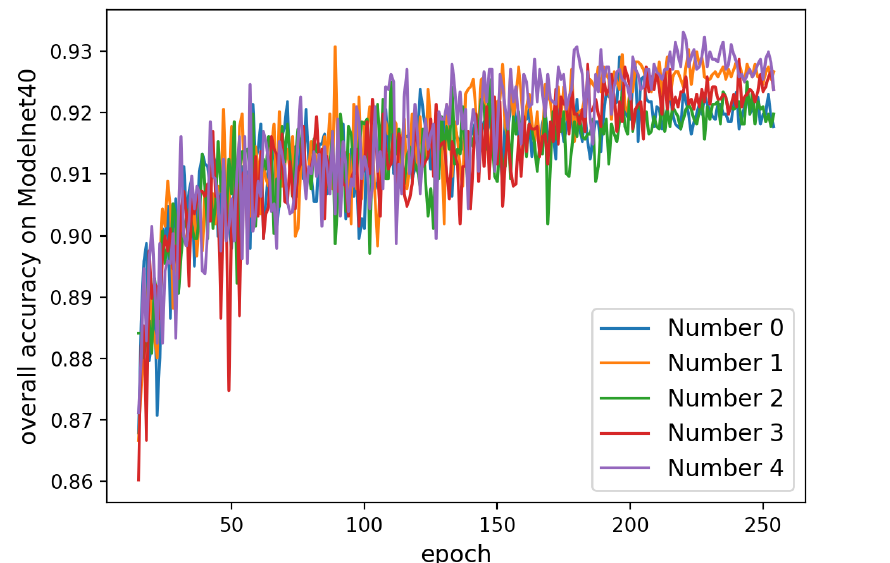
Figure 8. Overall accuracy of different models on ModelNet40 with epochs (epoch > 15). The models are defined according to Table 3 of the main text.